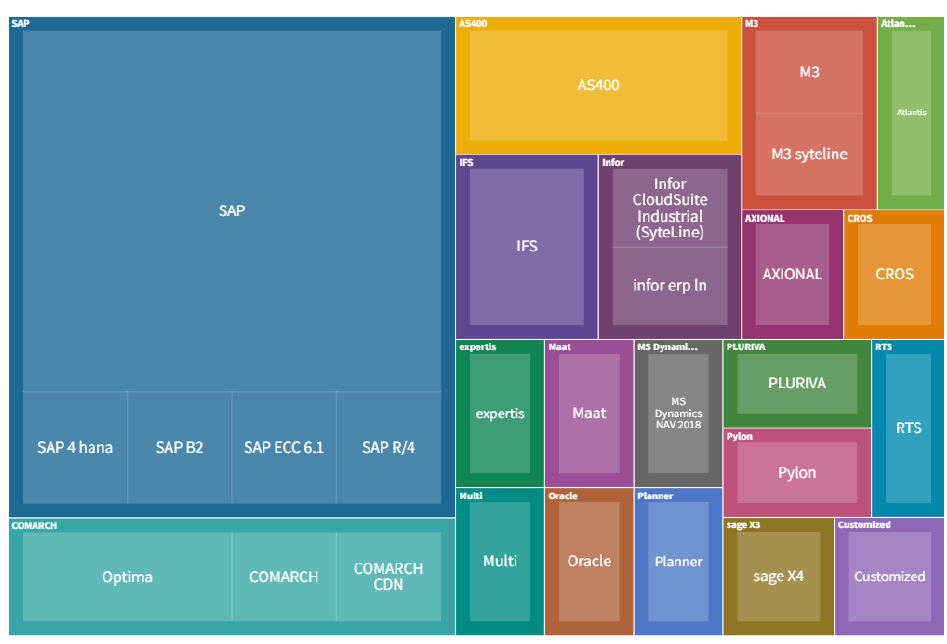
Figure 11. ERP systems are implemented in the companies.